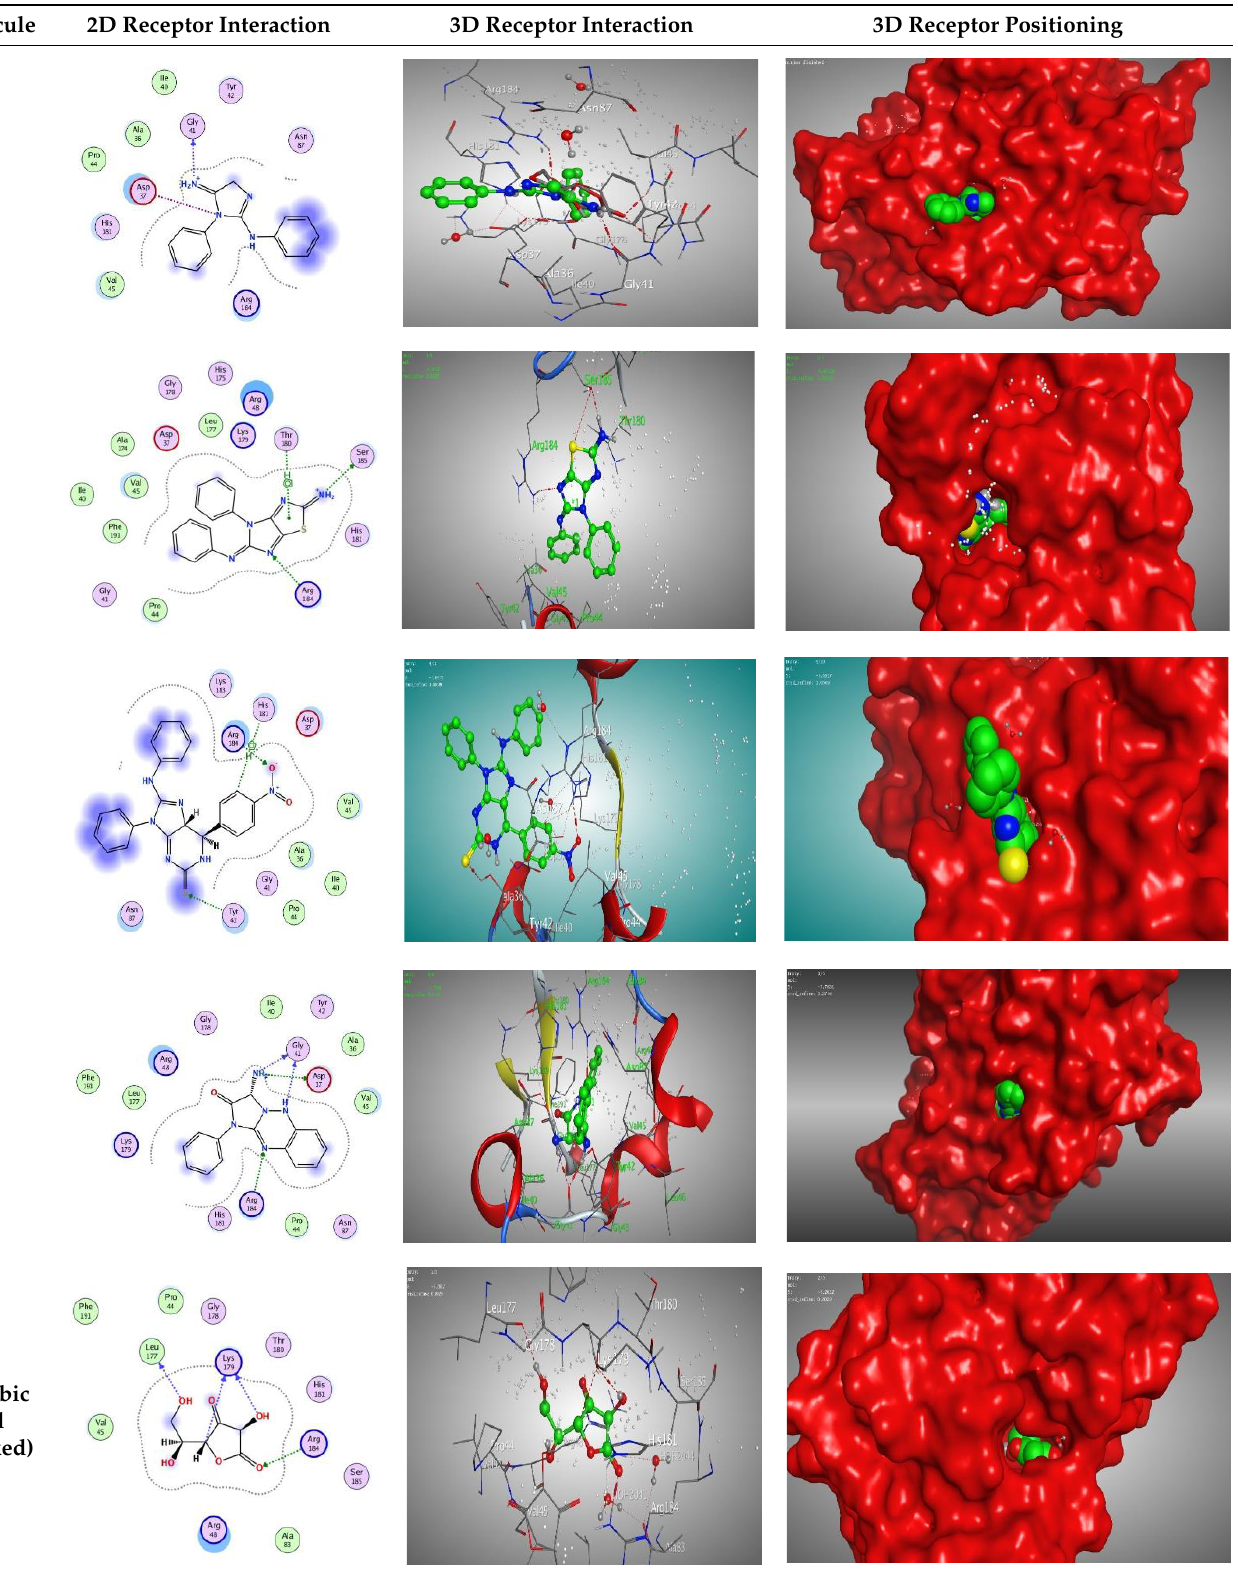
Table 4. 2D and 3D receptor interactions and receptor positioning of the most significant potential candidates ( 2 , 3 , 5 , and 6 ) compared to the docked ascorbic acid as a reference standard inside the binding pocket of cytochrome c peroxidase.